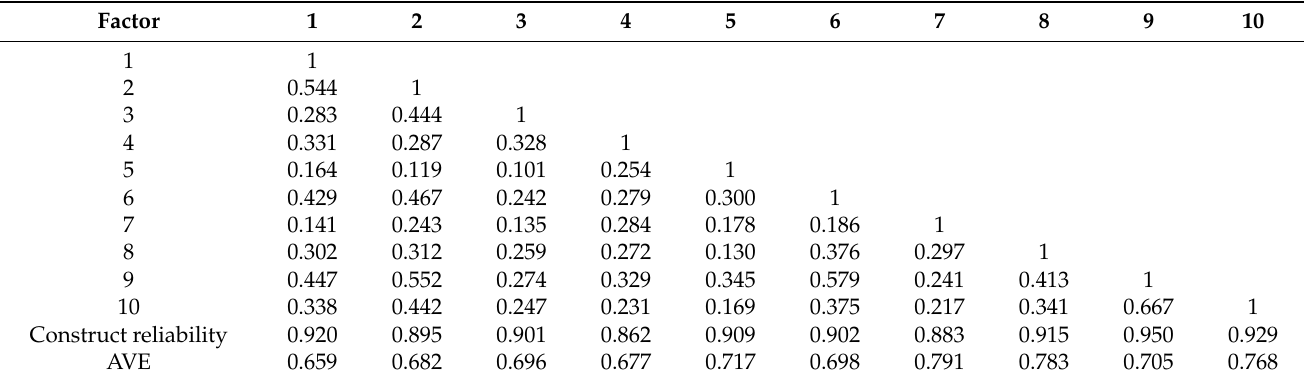
Table 8. The results of correlation